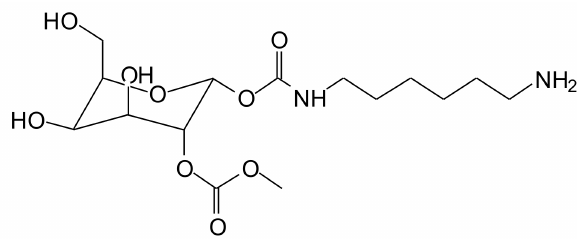
Figure 3. Example of a dicarbonated glucose having formed a urethane with hexamethylene diamine. 378.8 Da peak.